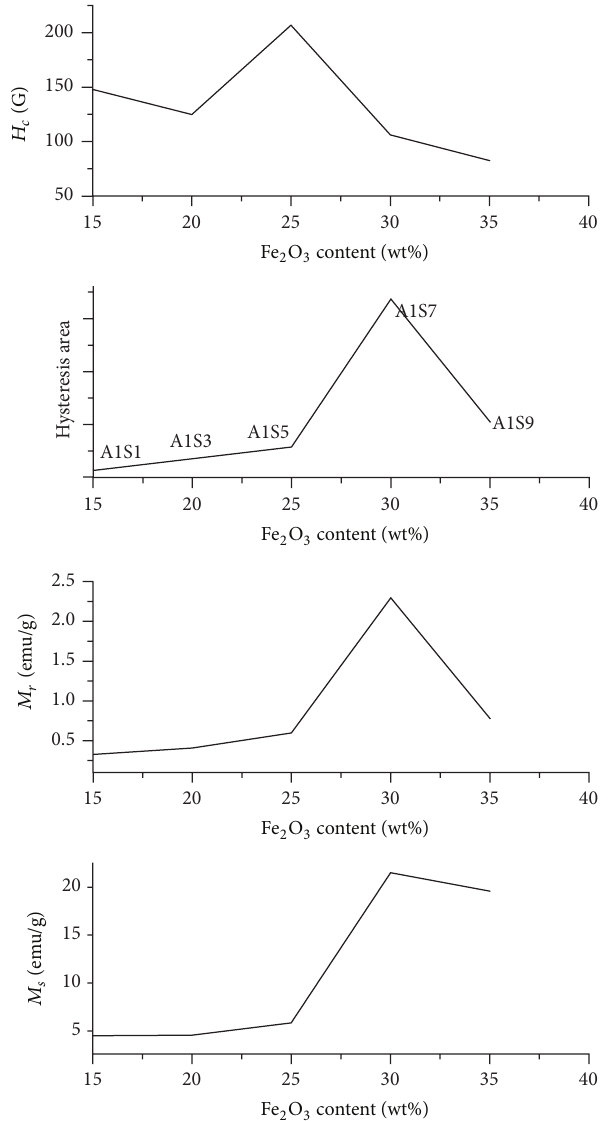
Figure 5: Relationship between magnetic properties and the Fe 2 O 3